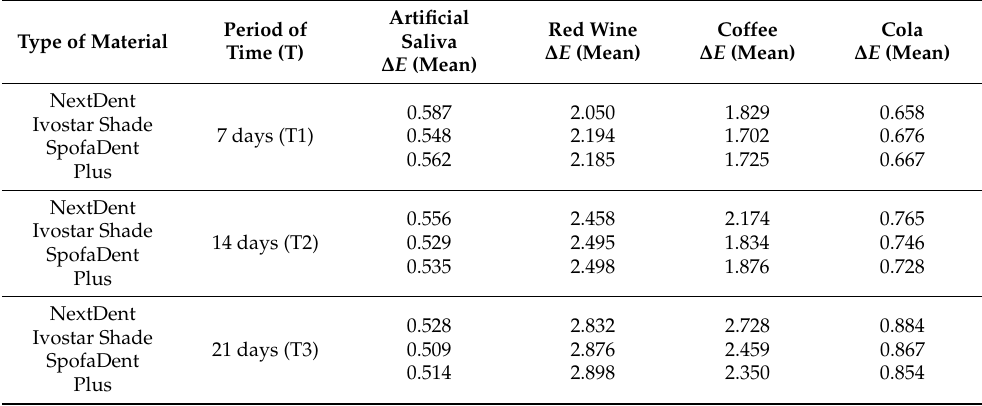
Table 4. Colour changes over time in different types of denture teeth ( ∆ E